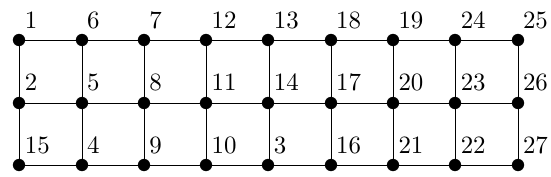
Figure 7: Prime labeling on P